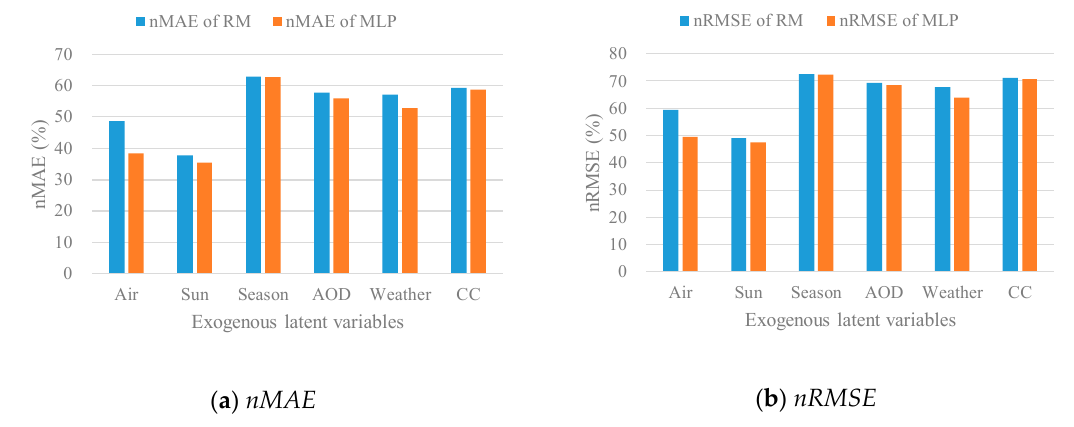
Figure 6. Performance of Regression Model (RM) and MLP models with different observation variables of exogenous latent variables based on Figure 4.